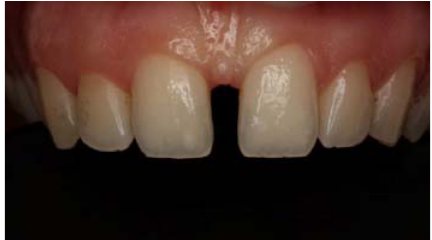
Figure 2: Preoperative intraoral view of the patient and the midline diastema.